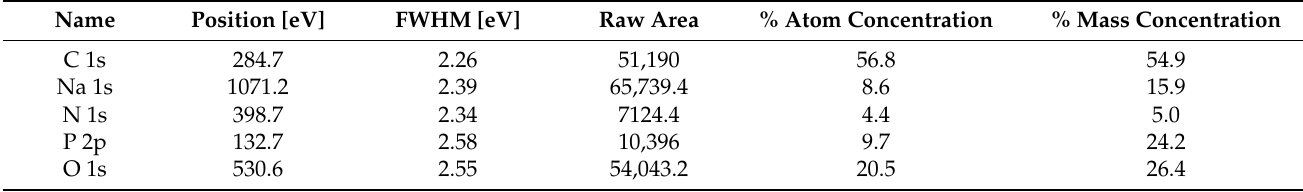
Table 4. The elemental composition of Purolite S 950 determined by the XPS method.